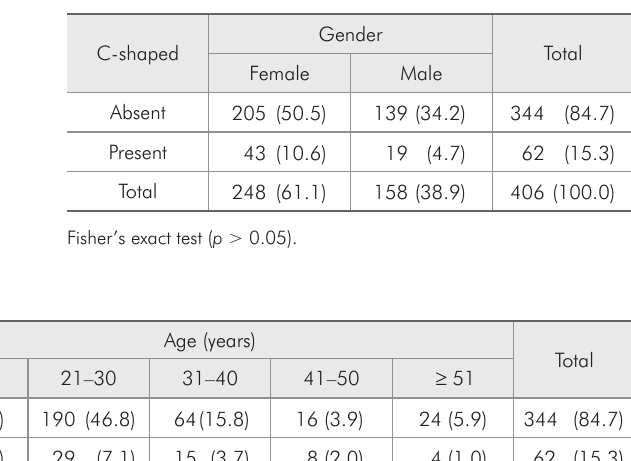
Table 1 - Frequency of C-shaped canals in mandibular sec- ond molars by gender [n ( %